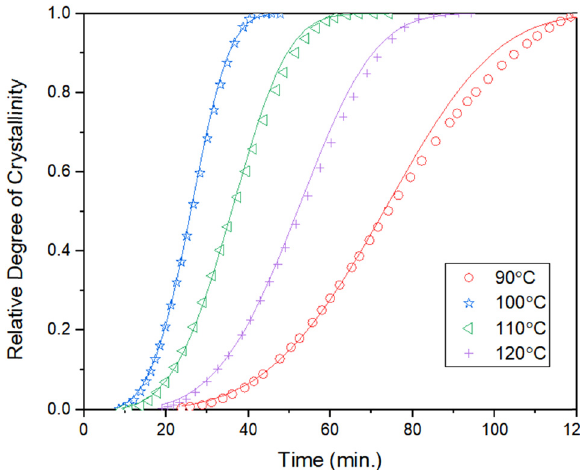
Figure 9: Plots of relative degree of crystallinity vs time for iso - thermal crystallization ( symbols: experiment data and solid lines: calculated using parameters n and k in Table 3 ) .